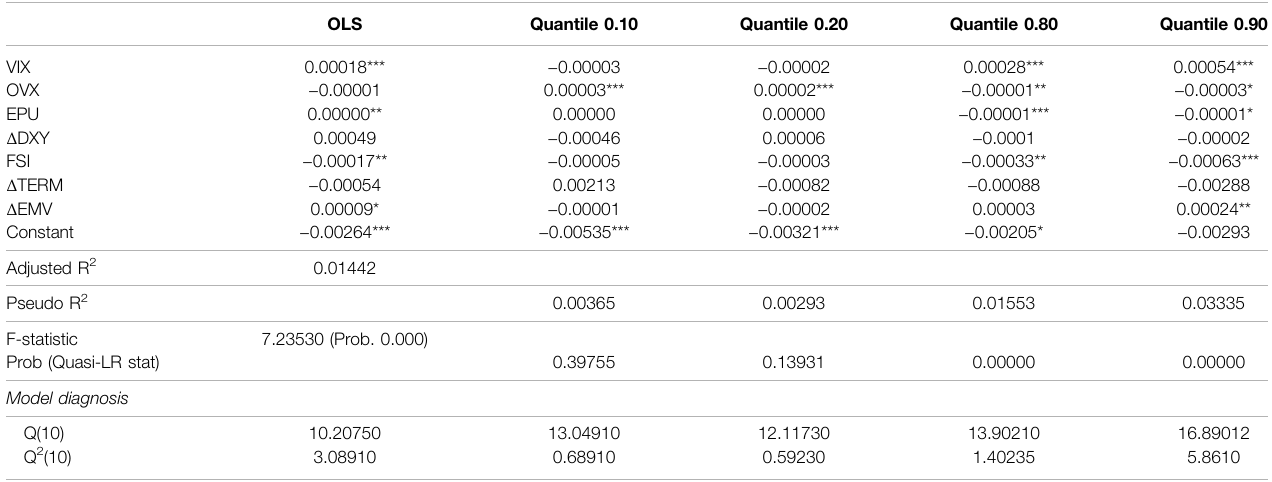
TABLE 4 | Drivers of return equicorrelation – OLS and quantile regressions.